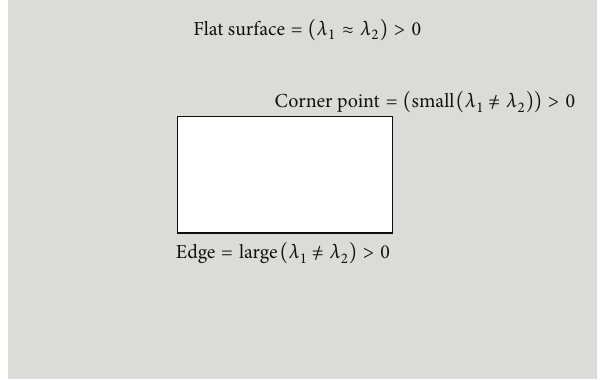
Figure 2: Eigen values of image pixels used to classify pixels as corner, edge, or representing flat